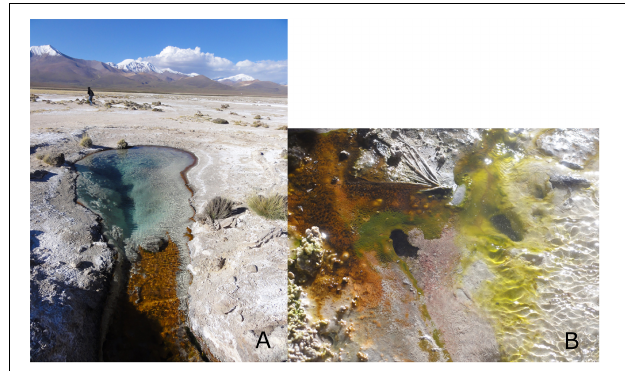
FIGURE 1 | (A) The sampling site of the geothermal pond in Lirima, Chile, from which S. ureilytica Lr5/4 was isolated. (B) A close-up photograph of the microbial